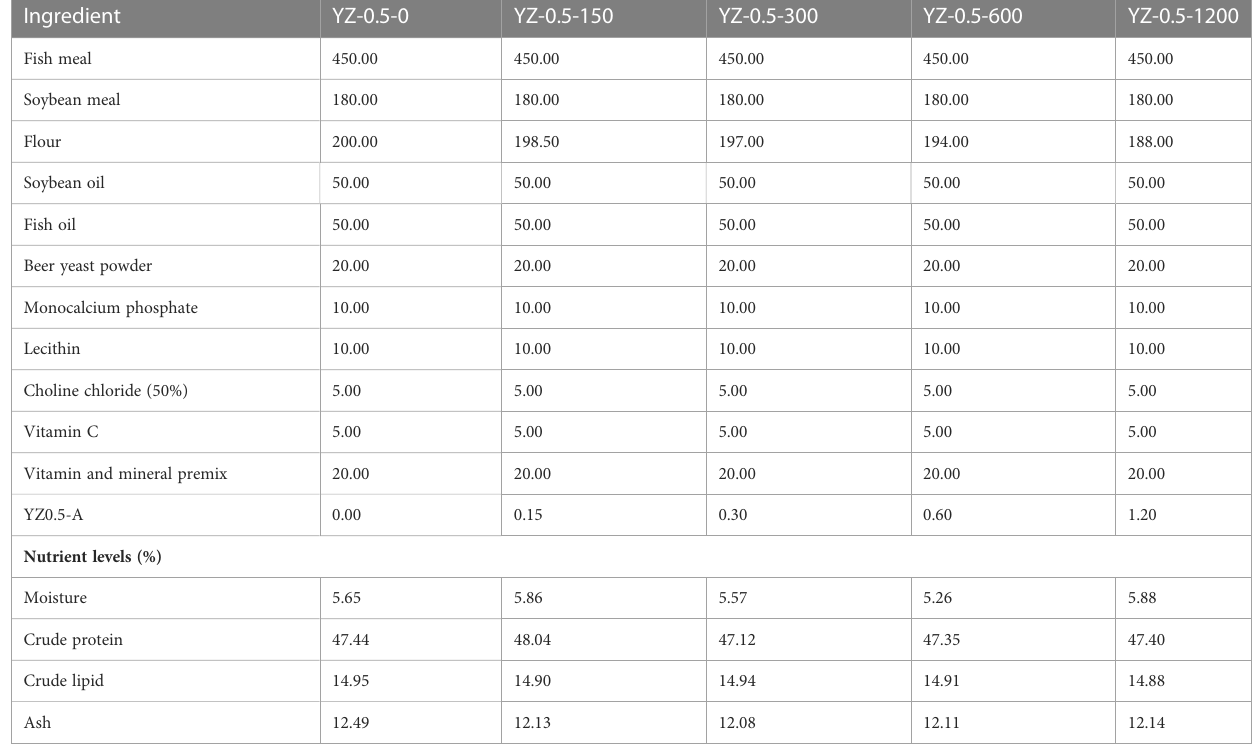
TABLE 1 Composition and nutrients in experimental diets